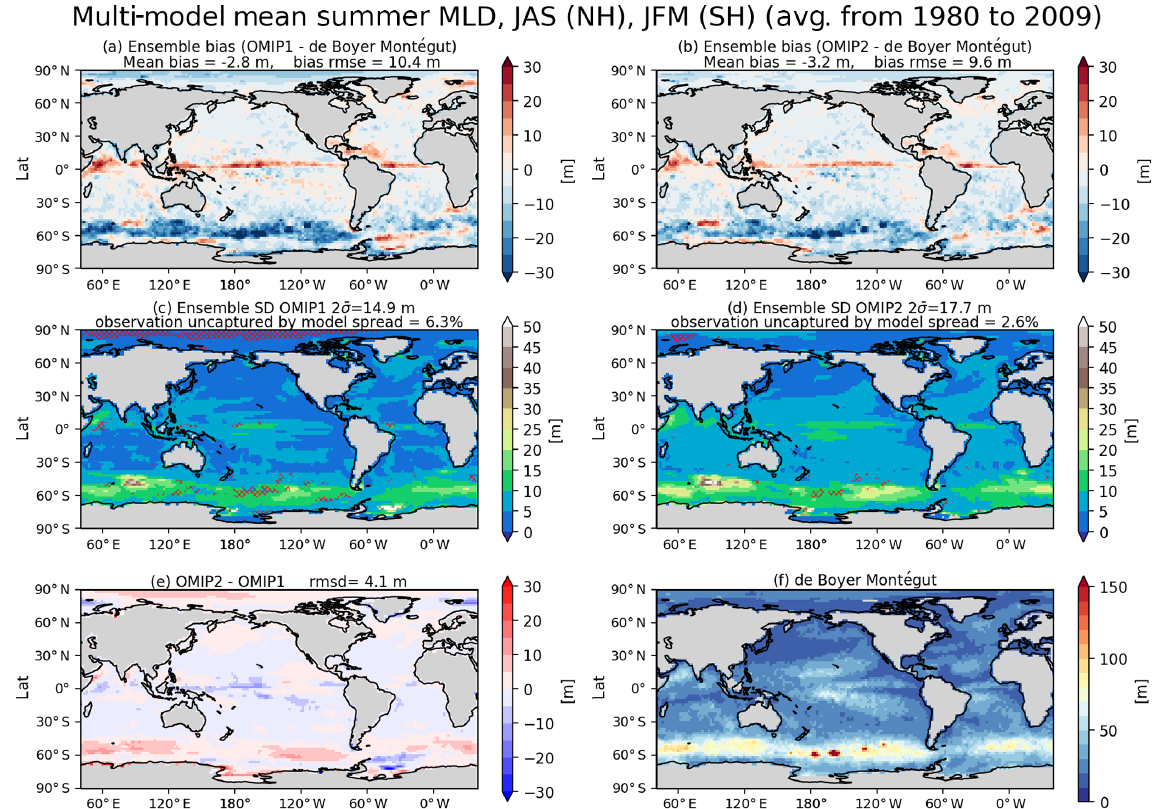
Figure 12. Same as Fig. 11 except for summer: July–August–September mean for the Northern Hemisphere and January–February–March mean for the Southern Hemisphere. The difference between OMIP-1 and OMIP-2 is not statistically significant at 95% confidence level everywhere. At the top of each panel, global mean values are depicted as in Fig. 6. For summer, the entire oceanic region is used to evaluate global means. See Figs. S30–S32 for results of individual